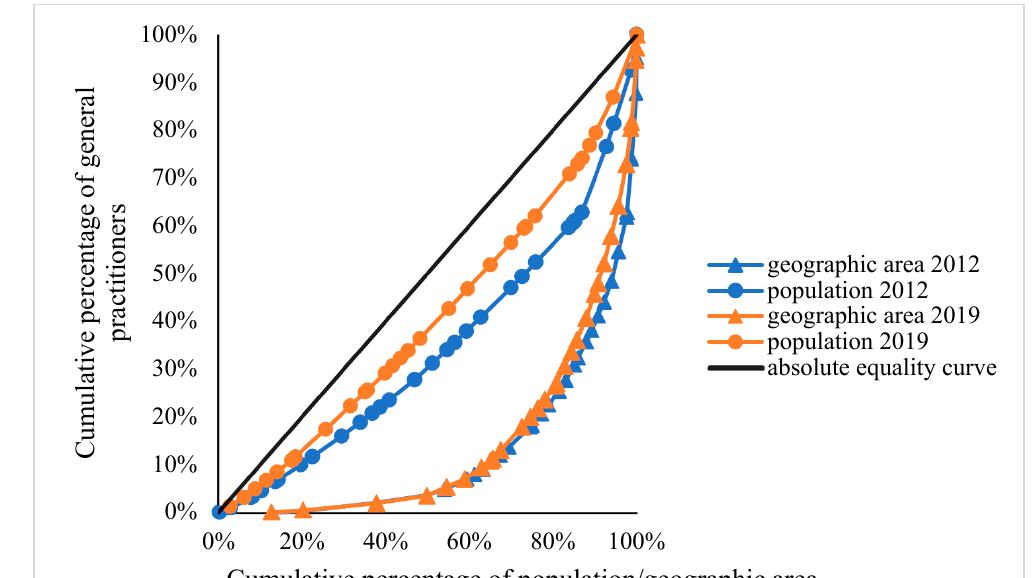
curve, while the Lorenz curves based on geographical area deviated considerably from the absolute equality curve. Table 6 shows that the Gini coefficient of GP allocation based on population decreased from 0.3123 in 2012 to 0.1872 in 2019. However, the Gini coefficient of GP allocation based on geographical area remained stable at 0.7108–0.7424. These findings demonstrate that GP allocation in mainland China based on population had relative equity, and even absolute equity in 2019, but that GP allocation based on geographical area had severe inequality.